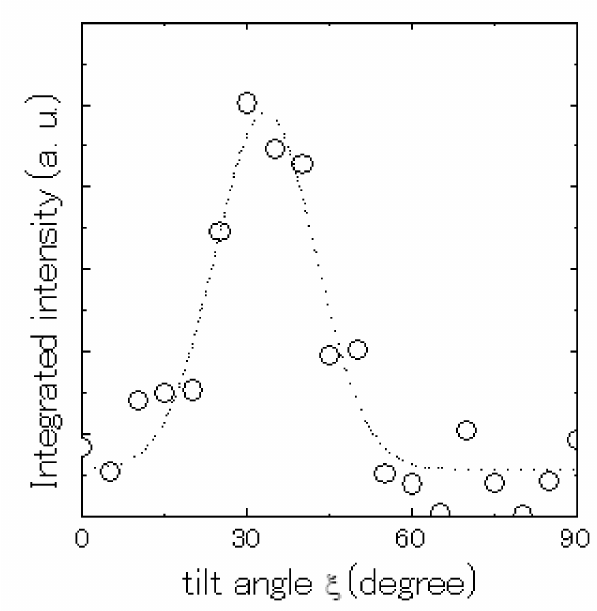
Figure 8. Integrated intensity of 110 reflection with variation in tilt angle ξ